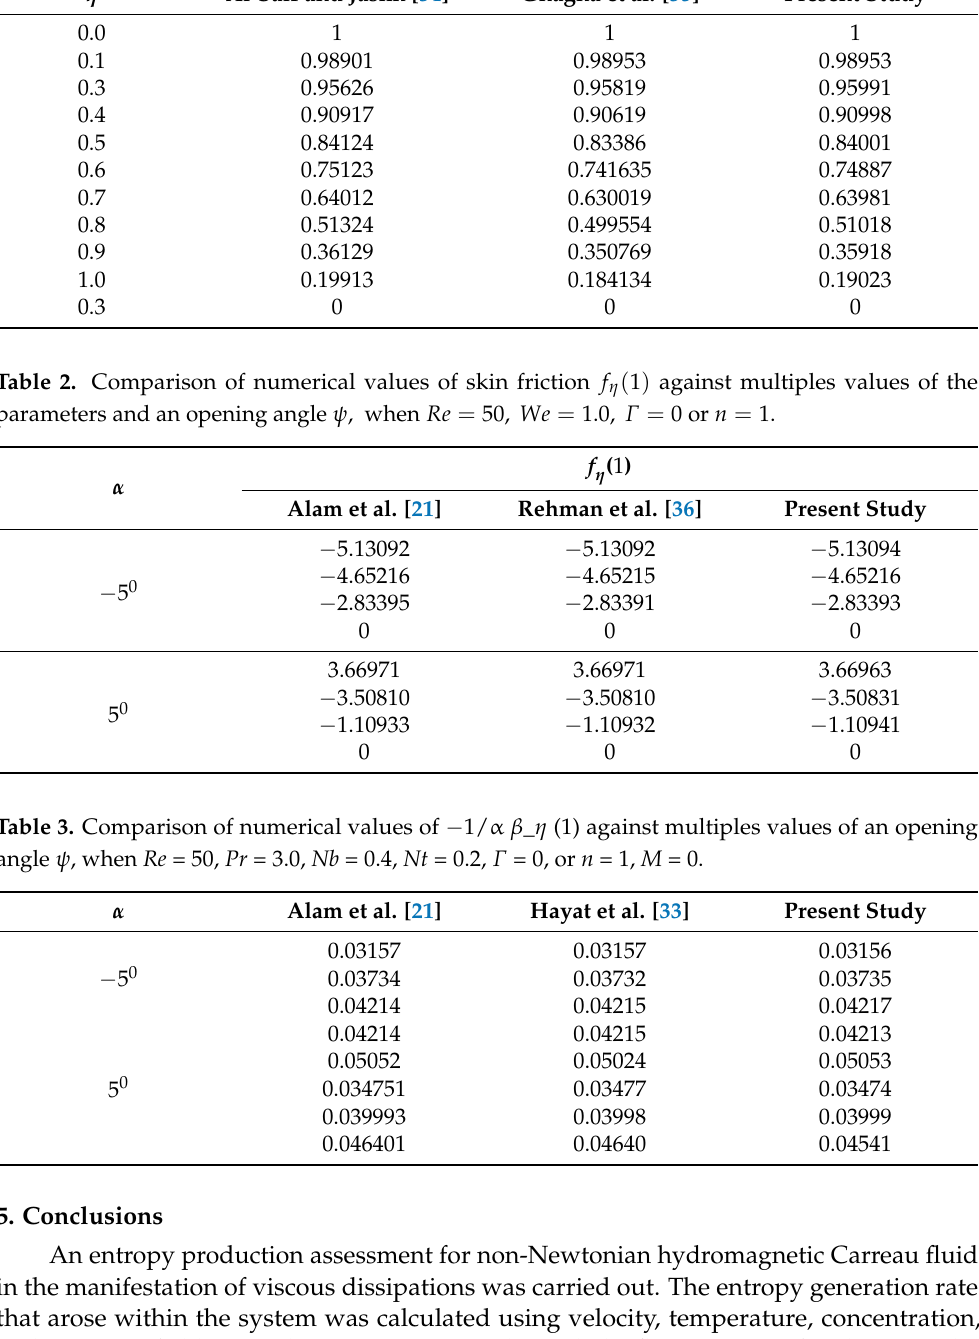
Table 1. Comparison of numerical values of f ( η ) against multiples values of an opening angle ψ = 3ˆ0, when Re = 4, We = 0, Γ = 0 or n = 1, M = 0.